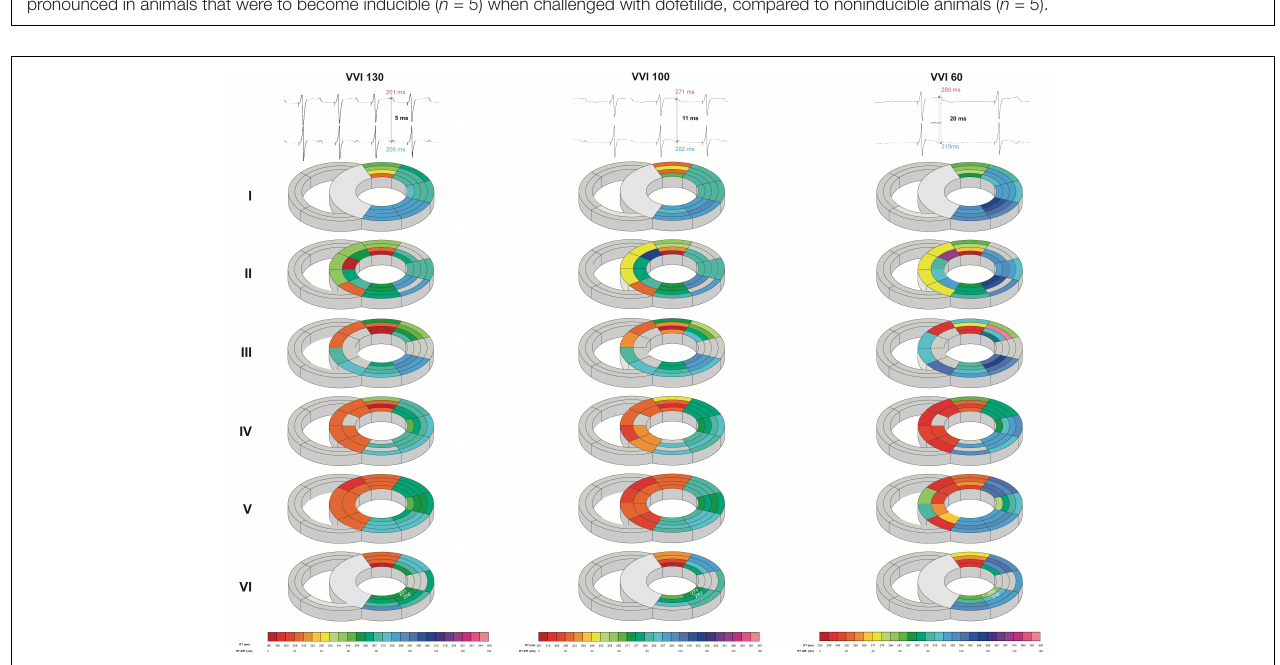
FIGURE 3 | Action recovery interval (ARI) restitution curves. (A) Increasing cycle length, and thus diastolic interval (DI), caused interventricular dispersion of ARI as the repolarization duration of the left ventricle prolonged more than the right ventricle. (B) The interventricular dyssynchrony in ARI prolongation (DARI) was more pronounced in animals that were to become inducible ( n = 5) when challenged with dofetilide, compared to noninducible animals ( n = 5).